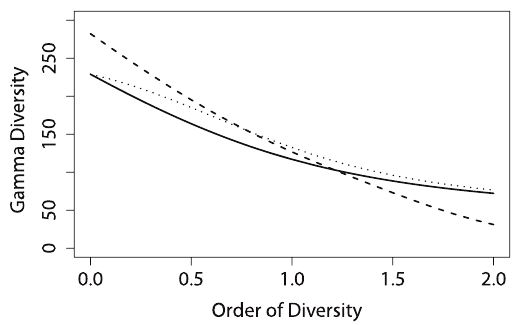
Figure 1. Profile of the c diversity in a tropical forest meta- community. Data from French Guiana, Paracou research station, 2 ha inventoried, 1124 individual trees, and 229 observed species. Solid line: without estimation bias correction; dotted line: Grassberger correction; dashed line: Chao and Shen correction. The maximum value is our bias- corrected estimator of diversity.